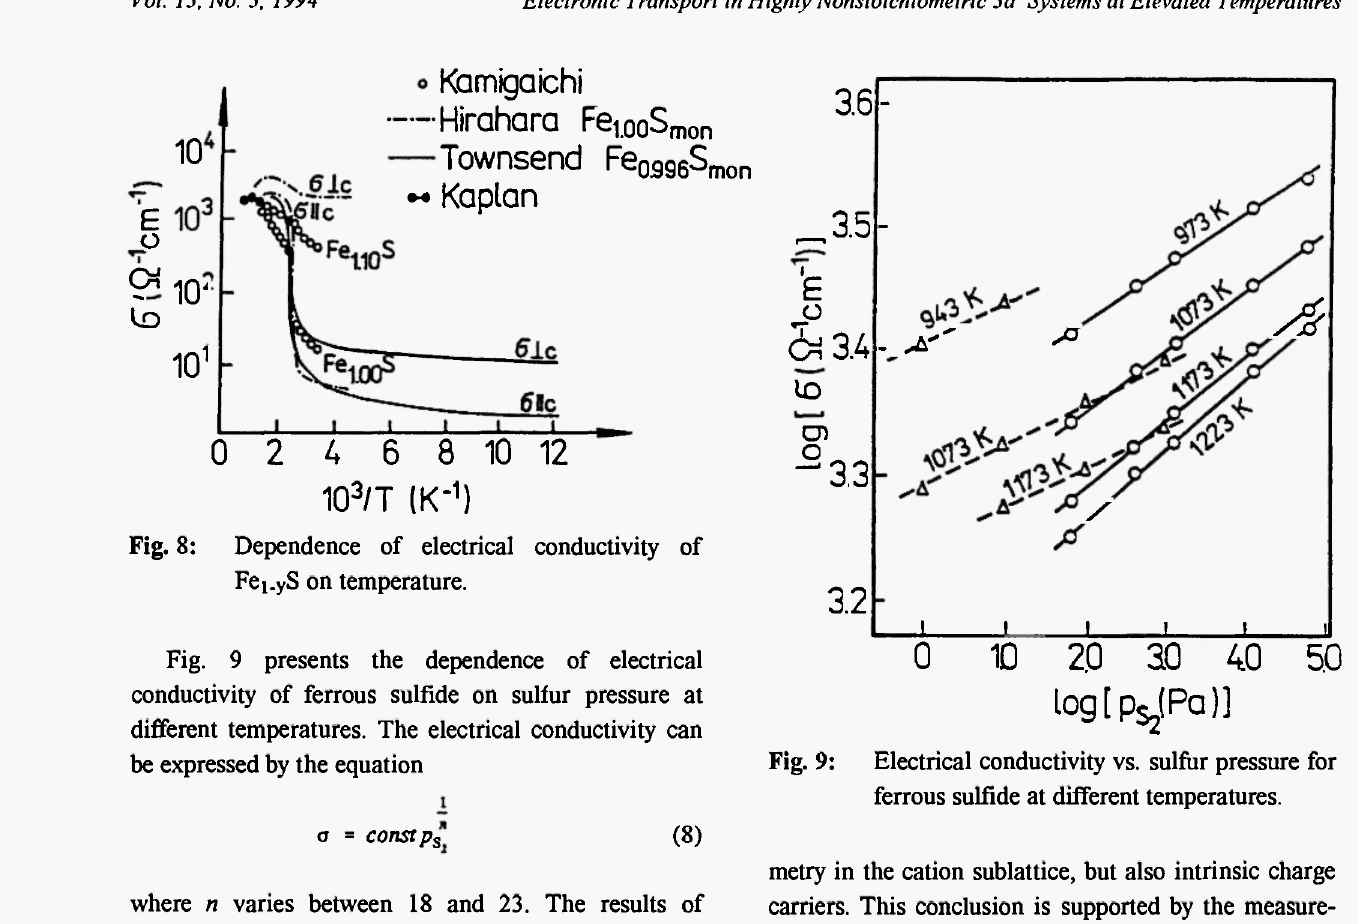
Fig. 9: Electrical conductivity vs. sulfur pressure for ferrous sulfide at different